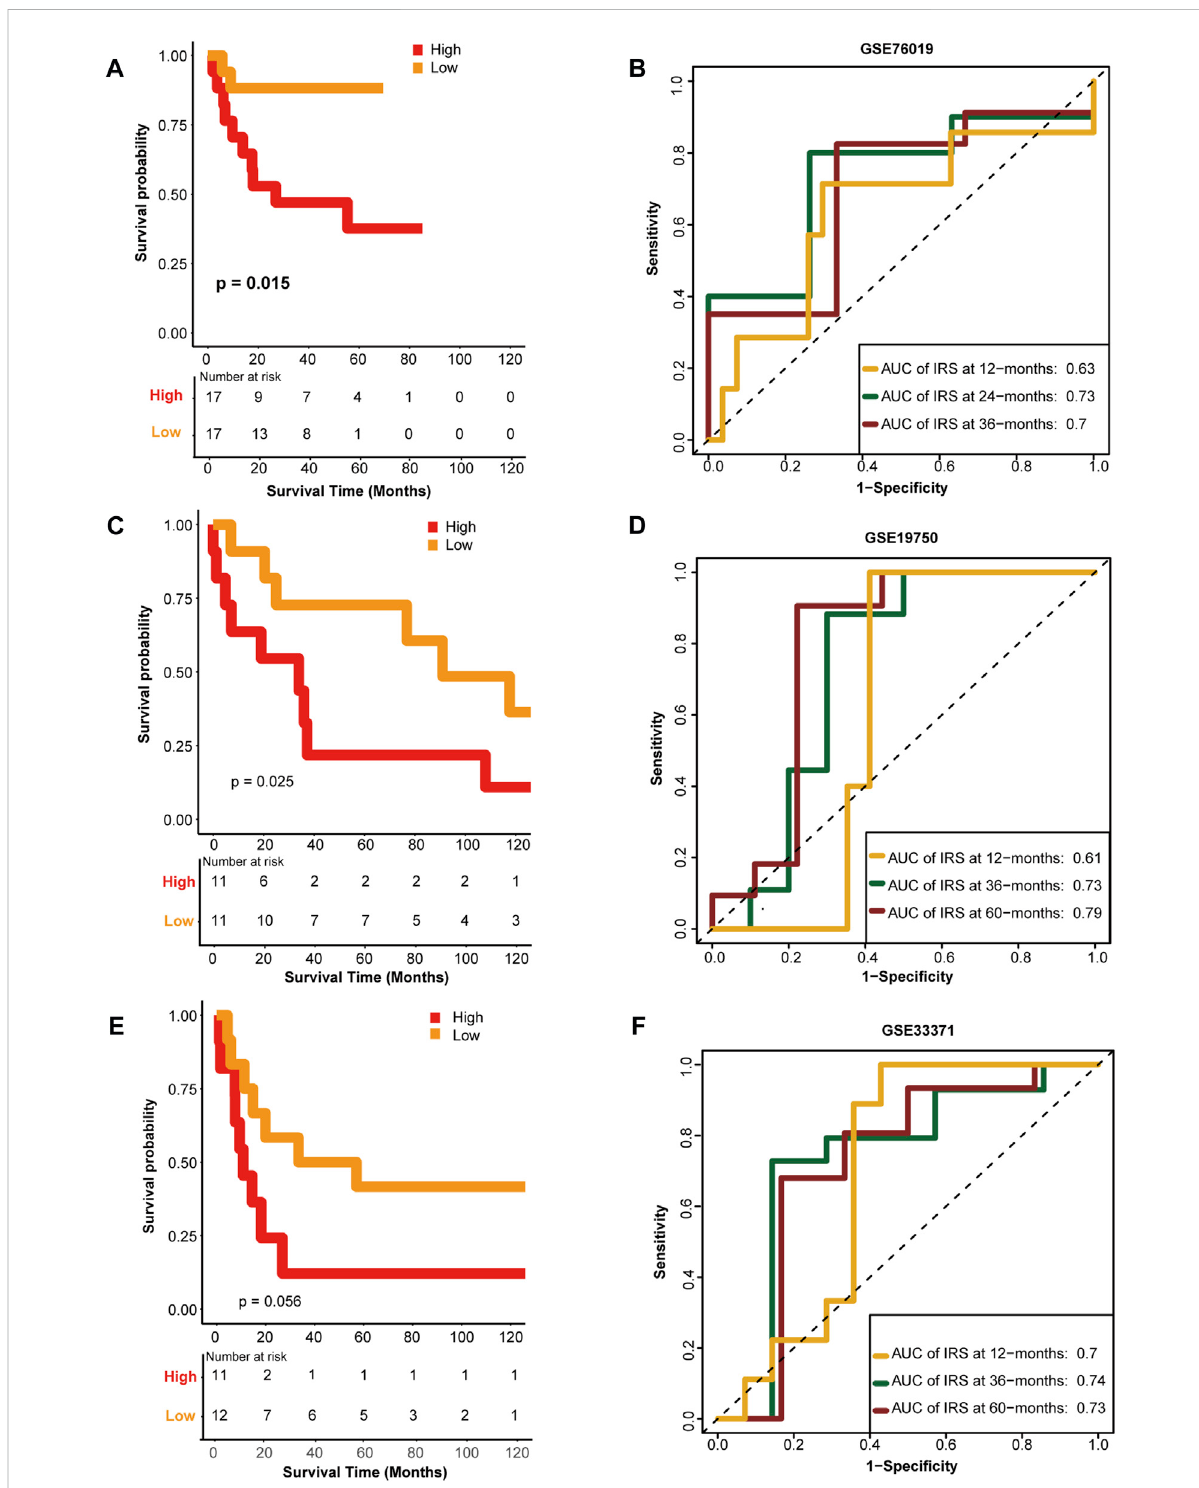
FIGURE 4 External validation of the hypoxia risk score. (A, B) Validation of the hypoxia risk score in GSE76019 (C, D) Validation of the hypoxia risk score in GSE19750 (E, F) Validation of the hypoxia risk score in GSE